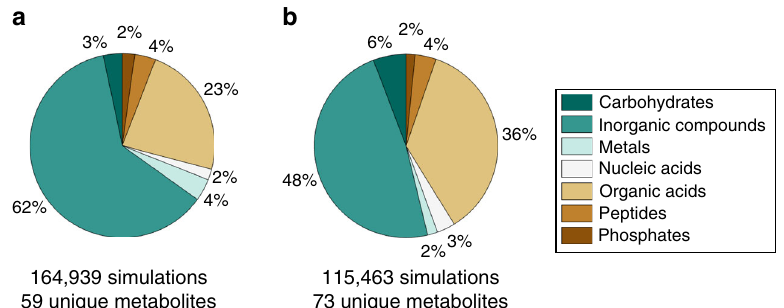
Fig. 3 Categorization of metabolites secreted costlessly in all simulations. a , b Categorization for all simulations with oxygen ( a ) and without oxygen ( b ). Though inorganic waste products (e.g., water, CO 2 ) make up the majority of unique metabolites secreted with and without oxygen, release of potentially valuable metabolites such as organic acids, carbohydrates, and peptides is observed in a major subset of simulations. In anoxic simulations in which at least one organism fully reduced nitrate into nitrogen gas, we observed a modest reduction in the number of fermentation byproducts